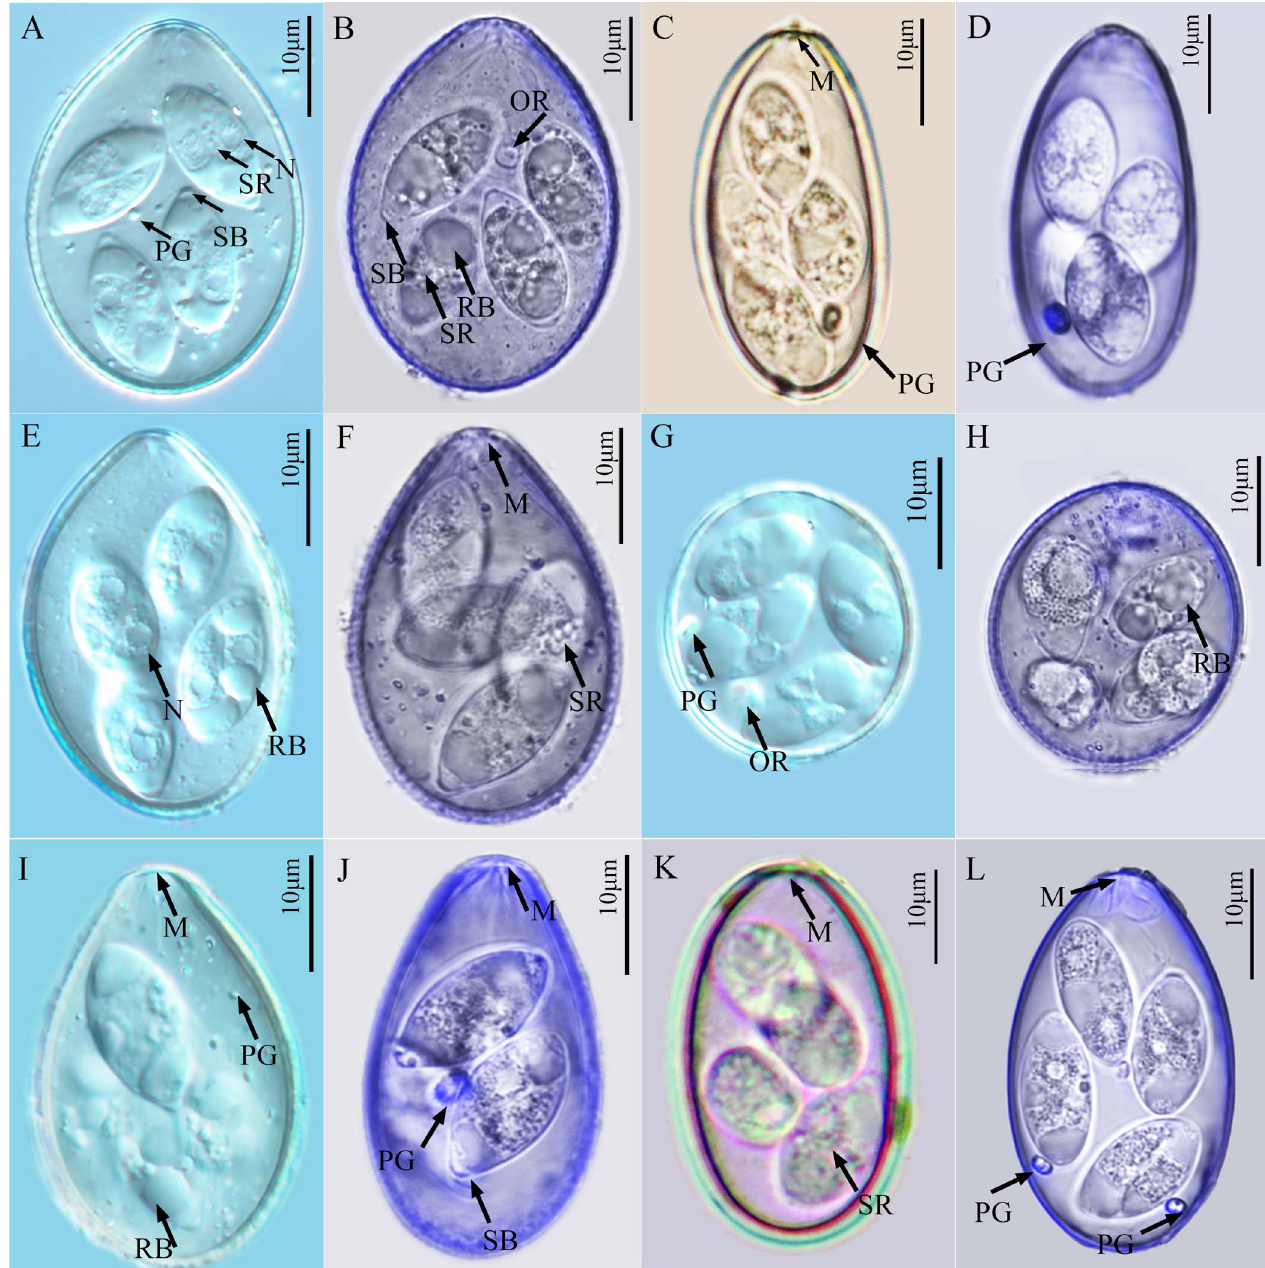
Figure 1. Photomicrographs of the sporulated oocysts of six Eimeria species collected from forest musk deer. A, B. Eimeria aquae n. sp.; C, D. Eimeria dolichocystis n. sp.; E, F. Eimeria fengxianensis n. sp.; G, H. Eimeria helini n. sp.; I, J. Eimeria kaii n. sp.; K, L. Eimeria oocylindrica n. sp.; Figs. A, E, G, I were obtained by differential interference contrast microscopy; Figs. B, D, F, H, J, L were obtained by confocal laser scanning microscopy; Figs. C, K were obtained under standard light microscopy under oil immersion. Abbreviations : M, micropyle; PG, polar granule; OR, oocyst residuum; RB, refractile body in sporozoite; SB, Stieda body on sporocyst; SR, sporocyst residuum; N, nucleus of